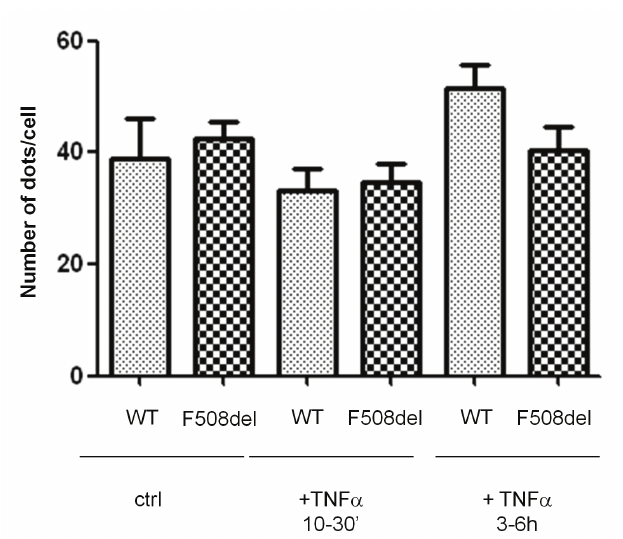
Supplementary Figure S1. Effect of TNF α on F508del-CFTR-NHERF1 proximity in expressing F508del-CFTR HeLa cells. Number of pairs F508del-CFTR-NHEFR1 in controls in TNF α -treated (as indicated) cells; Number of cells for control NHERF1-WTCFTR: 39 ± 13 n=90, NHERF1-F508del-CFTR: 42 ± 6, n= 80 cells; cells treated for 30min: NHERF1-WTCFTR 33 ± 7.7 n= 114 cells, NHERF1-F508del-CFTR 35 ± 7.1 n= 106; treated for 3 h: NHERF1-WTCFTR: 51 ± 9.1 n= 80 cells, NHERF1-F508del-CFTR: 40 ± 8.2 n=104 cells, p= NS in all